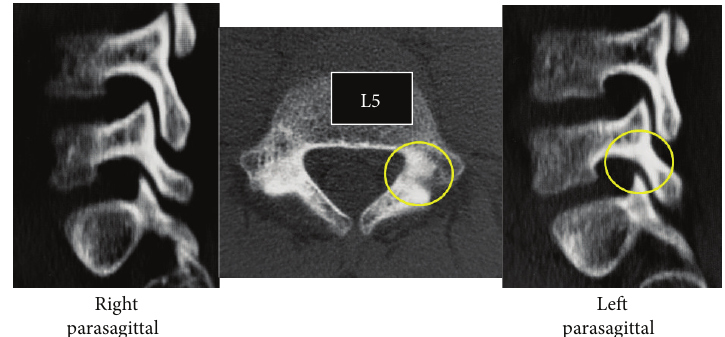
Figure 8: CT of Case 3. The left pars shows bony absorption, indicating the beginning of a stress fracture of the pars.